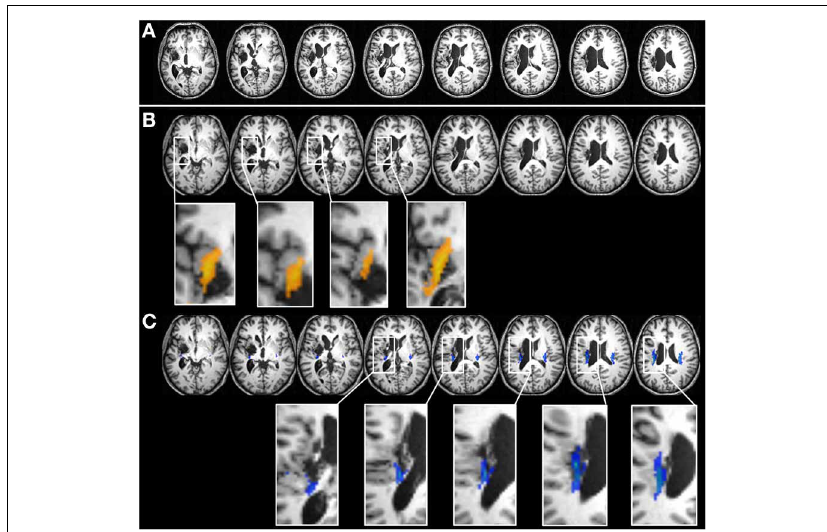
FIGURE 1 | Detailed views on the lesion of patient WT in axial orientation. (A) WT’s lesion in native space. (B,C) WT’s lesion transformed into MNI space. In (B) , the enlarged squares of specific slices ventral fiber tracts of the EC/EmC system are displayed additionally in orange. As can be seen from these detailed pictures, the ventral pathways connecting angular gyrus/temporal perisylvian language areas with Broca’s area in the inferior temporal gyrus (BA 45) are completely distrupted by the lesion. (C) Depicts the superior longitudinal fascicule (SLF) in a detailed view on patient WT’s brain in axial orientation (given in blue color). Again, as can be seen in the enlarged squares of specific slice, the dorsal SLF system is lesioned as well. Abbreviations: BA, Brodmann area; EC, external capsule; EmC, extreme